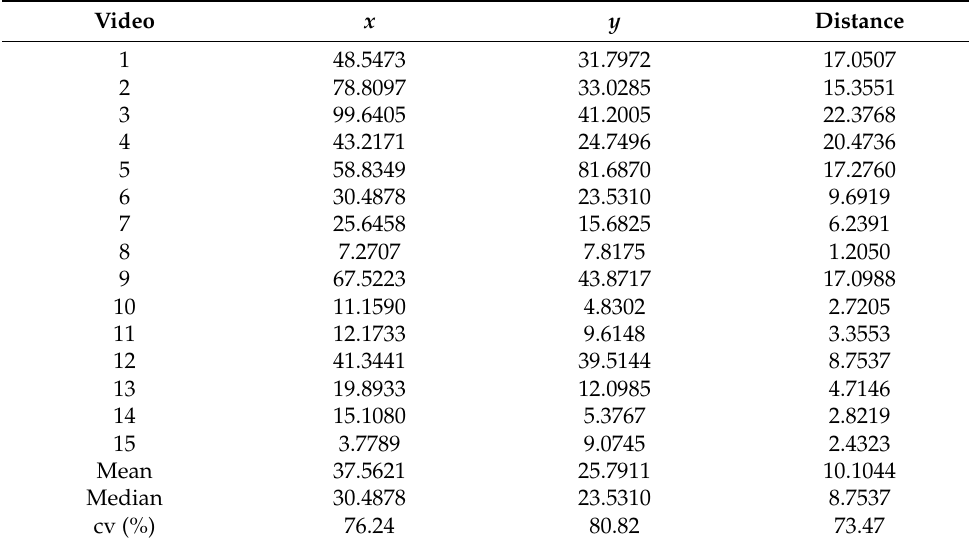
Table 5. The RMSE values (in pixels) of the forecasts for the x and y coordinates and the Euclidean distance between the forecast and gBest